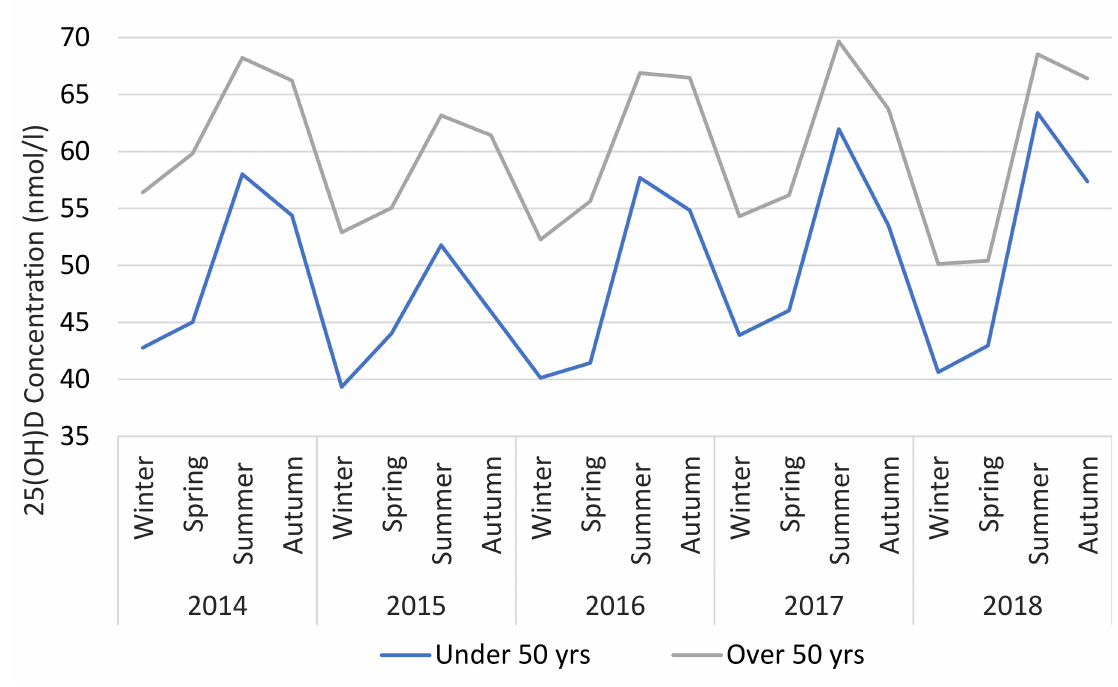
Figure 7. 25(OH)D status versus season, dichotomised by